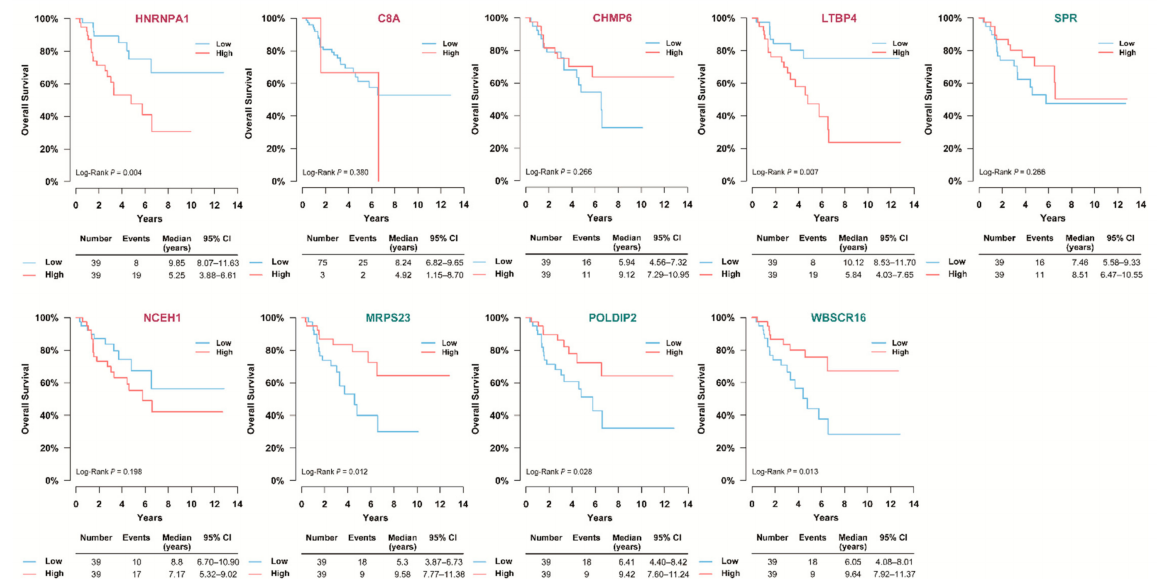
Figure 7. Kaplan–Meier analyses of significant DEPs in TCGA study. We tried to validate DEPs, which showed a significant difference in survival in the SNUH cohort, by performing Kaplan–Meier analyses in the TCGA study. It was analyzed by dividing it into low and high groups based on the median value. C8A—complement C8 alpha chain; CHMP6—charged multivesicular body protein 6; CI—confidence interval; DEP—differential expression of proteins; HNRNPA1—heterogeneous nuclear ribonucleo-protein A1; LTBP4—latent transforming growth factor beta binding protein 4; MRPS23—mitochondrial ribosomal protein S23; NCEH1—neutral cholesterol ester hydrolase 1; POLDIP2—polymerase delta-interacting protein 2; SPR— sepiapterin reductase; TCGA—The Cancer Genome Atlas; WBSCR16—Williams-Beuren syndrome chromosome region 16.